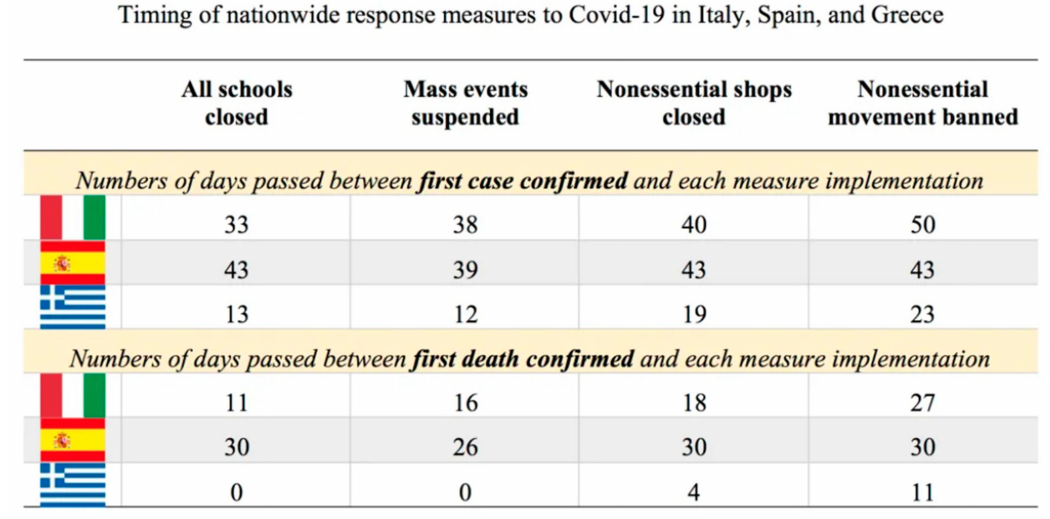
Scheme 6. Comparison between Greece, Italy and Spain on the timing of nationwide response measures